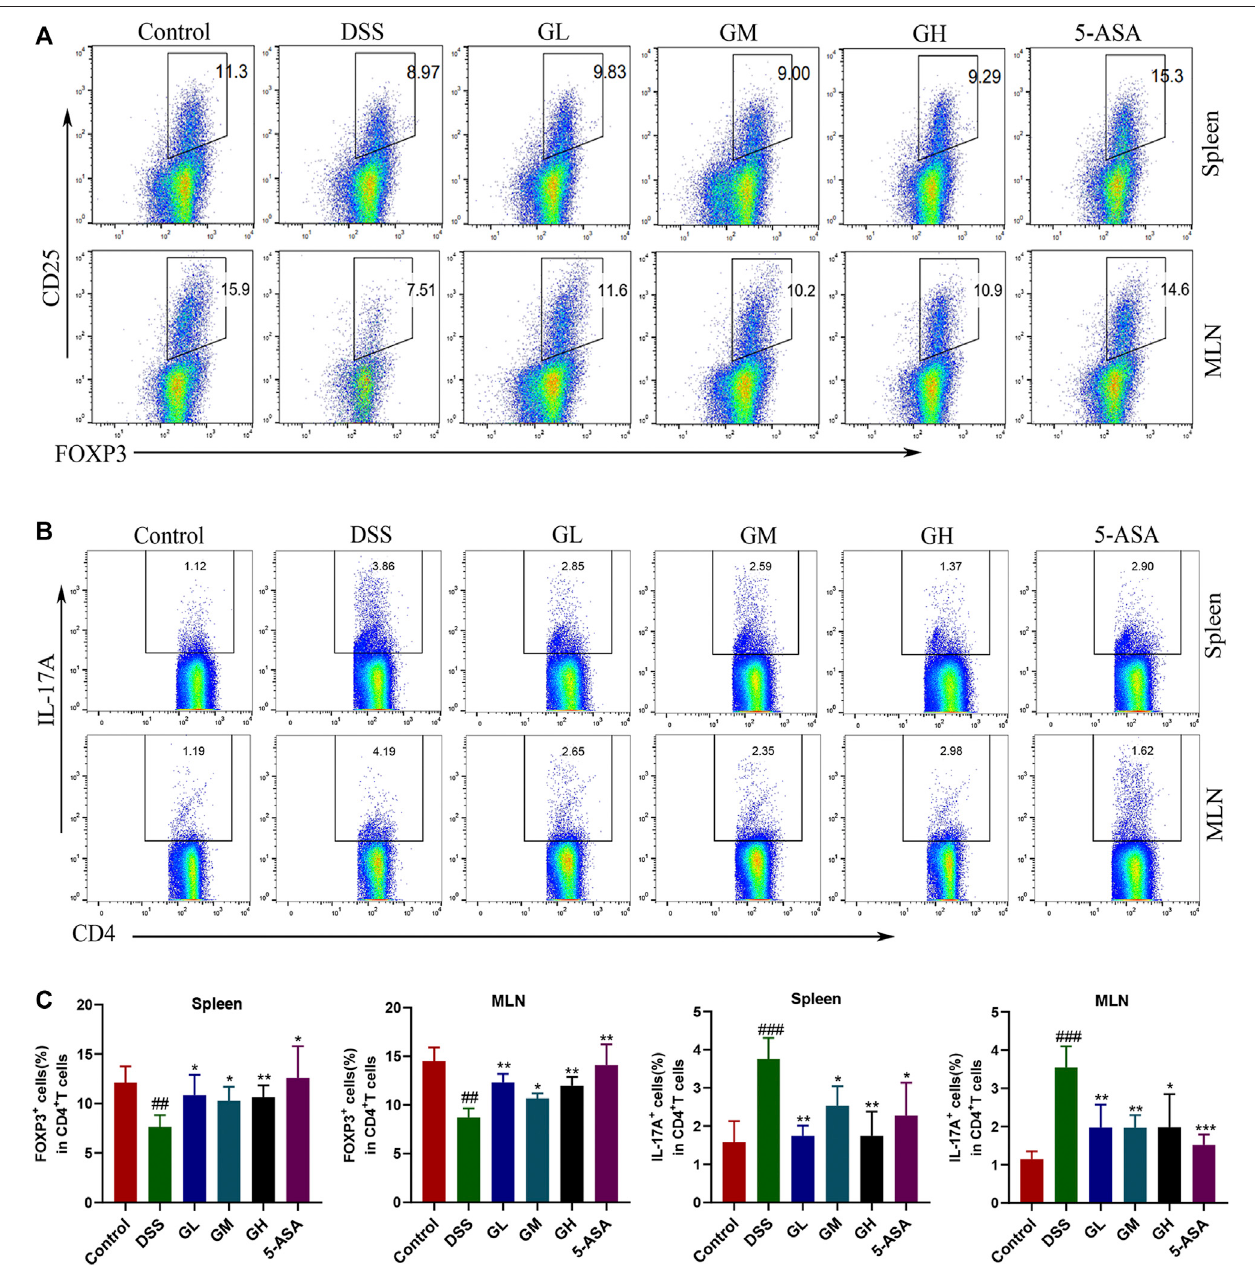
FIGURE 11 | MGQD traetment regulated the proportion of Treg cells and Th17 cells in splenocytes and mesenteric lymph nodes (MLNs) in UC mice. (A) Effect of MGQD on the proportion of CD4 + CD25 + Foxp3+ (Treg) cells in the spleen and MLNs of mice with colitis were analyzed by fl ow cytometry. (B) Effect of MGQD on the proportionofCD4+IL-17A+(Th17)cellsinthespleenandMLNsofmicewithcolitis. (C) QuantitativeanalysisofTregandTh17cellsinsplenocytesandMLNs. Datawere expressed as mean ± SD (n (cid:2) 3 – 5). ## p < 0.01, ### p < 0.001, vs control group; * p < 0.05, ** p < 0.01, vs DSS